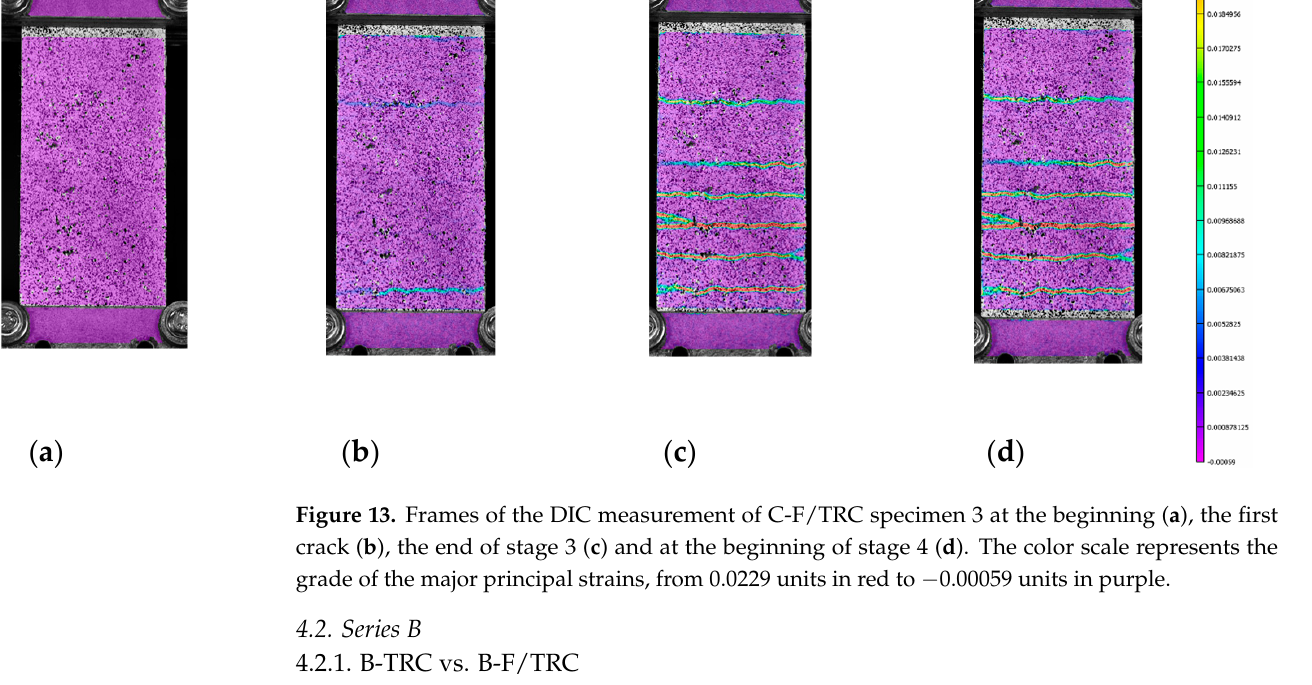
The test results of the B-TRC specimens of series B are represented by force–displacement and stress–strain curves in Figure 14a,b.